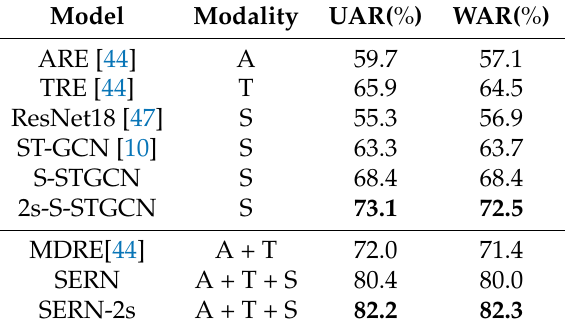
Table 1. Comparison with baselines. We compare the performance of both the unimodal and multimodal models, for which A is the audio modality, T is the text transcription, and S is the skeleton data. SERN-2s is a skeleton enhanced emotion recognition network whose S-STGCN is replaced with